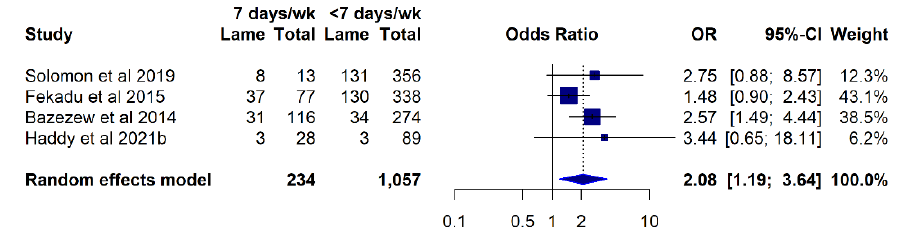
Figure 6. A meta-analysis of studies investigating working equid lameness in low- and middle-income countries ranging from 2003 to 2021, with available data for the prevalence of lameness according to number of days worked per week: Solomon et al. 2019 [47], Fekadu et al. 2015 [49], Bazezew et al. 2014 [16], Haddy et al. 2021b [34]. The reference category is listed on the right.